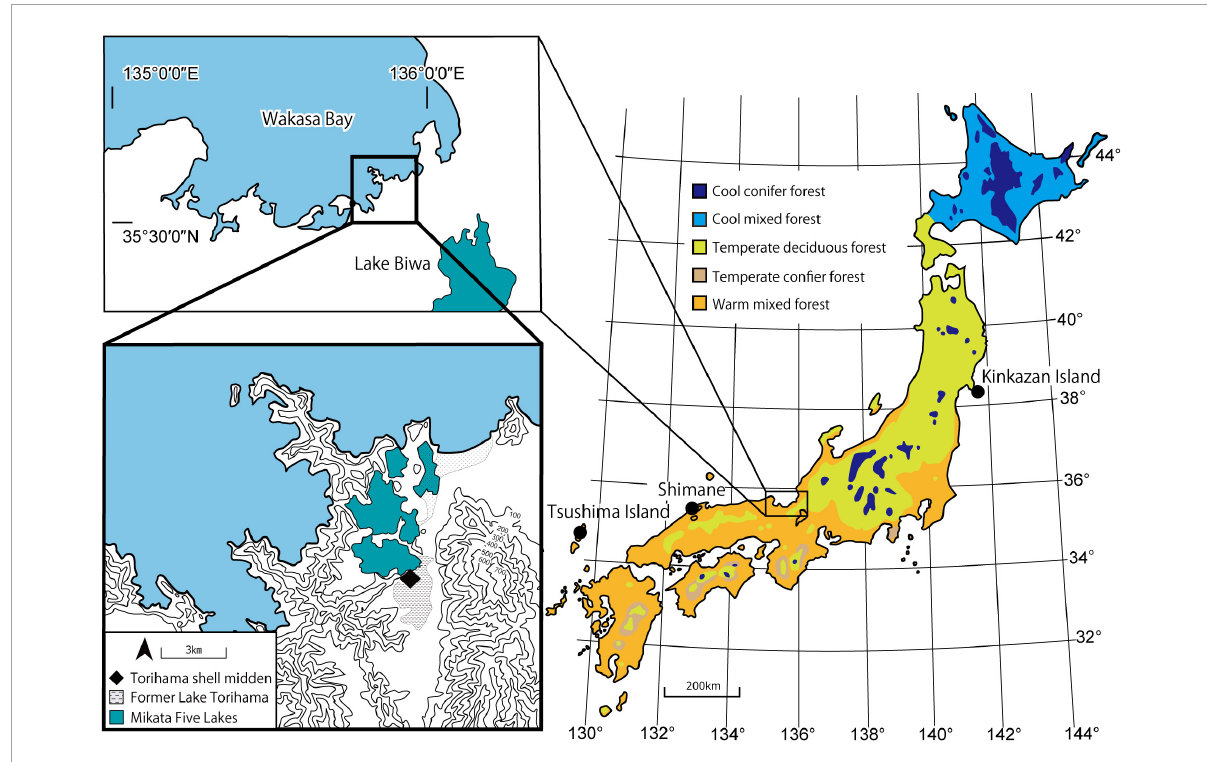
FIGURE1 Location of Torihama Shell Midden ( ); location of comparative specimen collection ( ). We based the estimated shoreline of the Jomon period and the location of former Lake Torihama on Morikawa (2002) and the present vegetation classification on Yoshioka